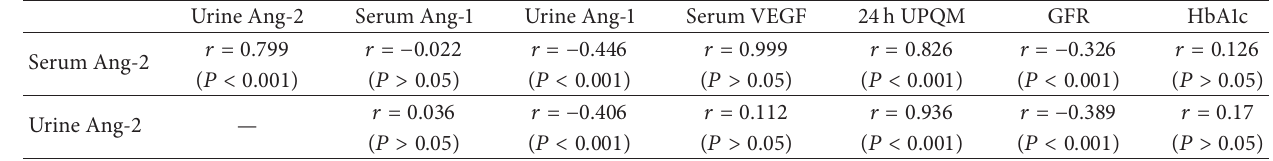
Table 2: Correlations between potential markers of DN.